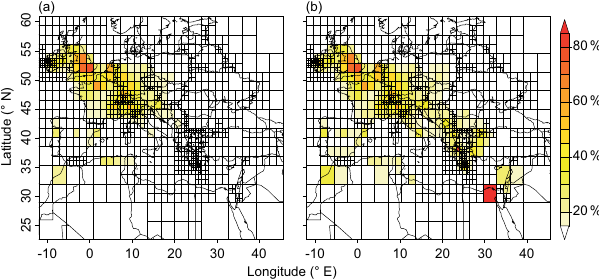
Figure 11. HFC-134a uncertainty reduction (%) achieved by (a) the inversion excluding observations from Finokalia (S-NFKL) and (b) the BASE inversion using observations from all four sites in- cluding